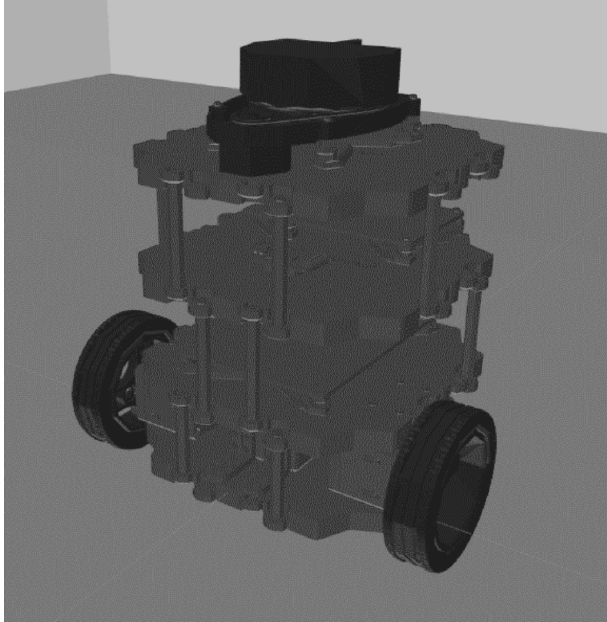
Figure 1. Simulated mobile